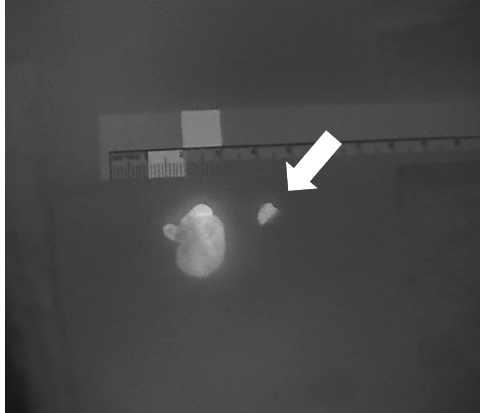
Figure 5. A resected parathyroid adenoma in comparison to a normal parathyroid gland (arrow) .